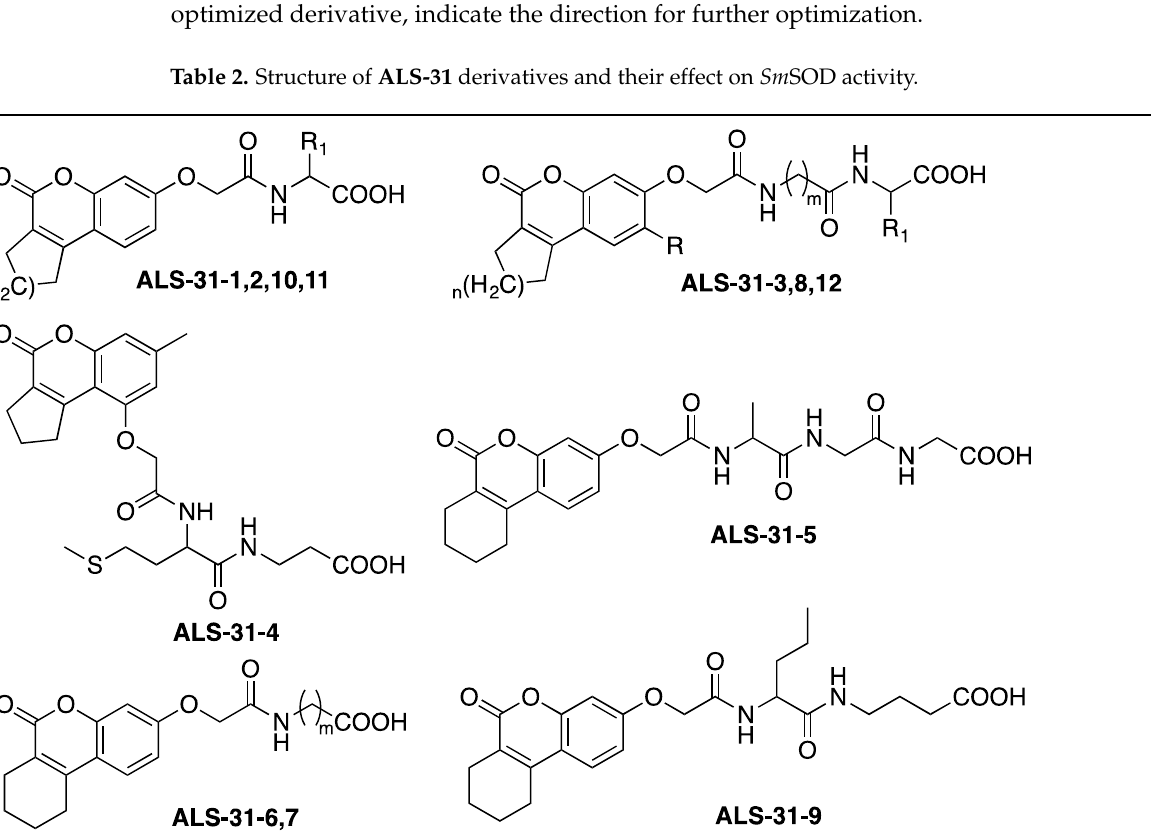
Figure 7. ( A ) Predicted binding mode of compound ALS-31 (displayed as pink sticks) at the dimer interface of Sm SOD (PDB 4YIP). The amino acid side chains important for ligand binding are repre- sented as sticks and labelled. The metal ion is represented as an orange sphere. Hydrogen bonds are shown as black dashed lines. ( B ) 2D ligand interaction diagram of compound ALS-31 . Positively charged amino acids are represented with dark blue drops, negatively charged amino acids are rep- resented with red drops, polar amino acids are represented with light blue drops and hydrophobic amino acids are represented with green drops. H-bonds are depicted with purple arrows. Straight red lines represent cation- π interactions. ( C ) Superposition of ALS-31 docked pose with monomer A residues E165 and S126 (displayed as yellow sticks).